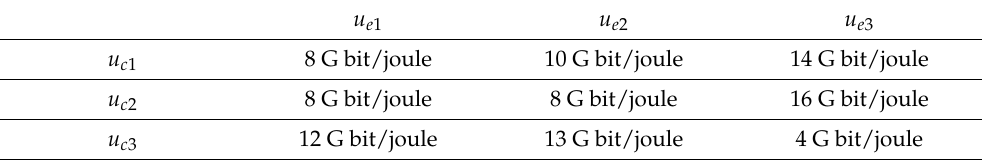
Table 2. An example of the optimization objective matrix for the Hungarian